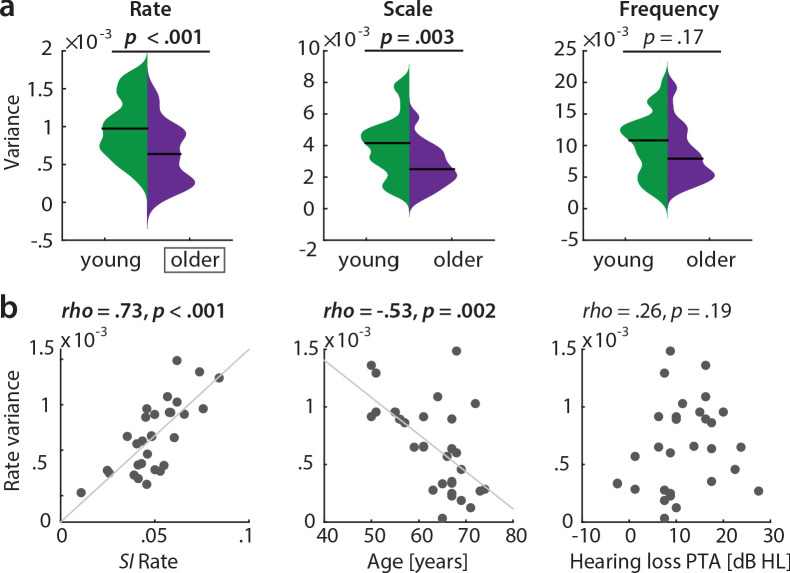
Variance along reconstruction accuracy profiles as alternative measure for cortical tuning selectivity.(a) Variance of the MTFs’ marginal profiles compared between age groups. P-values are based on an exact permutation test. (b) Amongst the older group, the variance of the rate profiles (‘rate variance’) correlates with the SI for rate (left panel) and chronological age (middle panel), but not with hearing loss (right panel; Spearman’s correlation coefficient). MTF: modulation transfer function, SI: selectivity index, PTA: pure tone average.